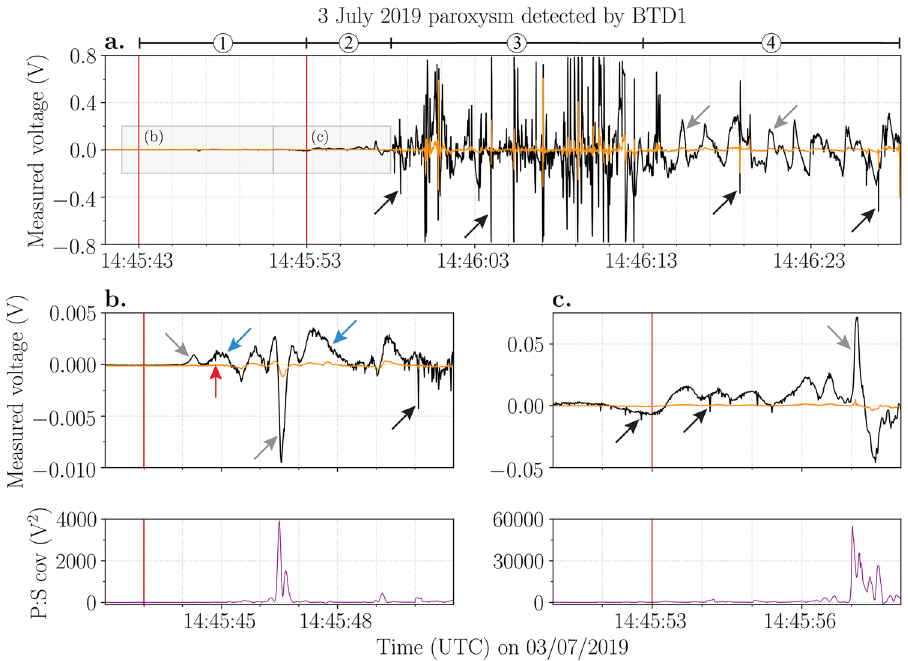
Figure 5. Voltage (V) measured by the primary (black line) and secondary (orange line) antennas of BTD1 during the 3 July 2019 paroxysm. The red vertical lines pinpoint two separate explosions at 14:45:43 and 14:45:53 UTC, respectively. Examples of movement of charge and electrical discharges are indicated by the grey and black arrows, respectively. ( a ) The entire electrical signal of the paroxysm until the power cut. Four different phases (1–4) of electrical activity can be distinguished. ( b ) The electrical signals recorded during the first explosion with their corresponding covariance (V 2 ) below. The red arrow marks the first electrical discharge and the blue arrows mark small irregular variations in the electrical signal likely caused by pyroclasts moving towards BTD1. ( c ) The electrical signals recorded during the second explosion with their corresponding covariance (V 2 ) below. Note the different scale on the y-axis of each